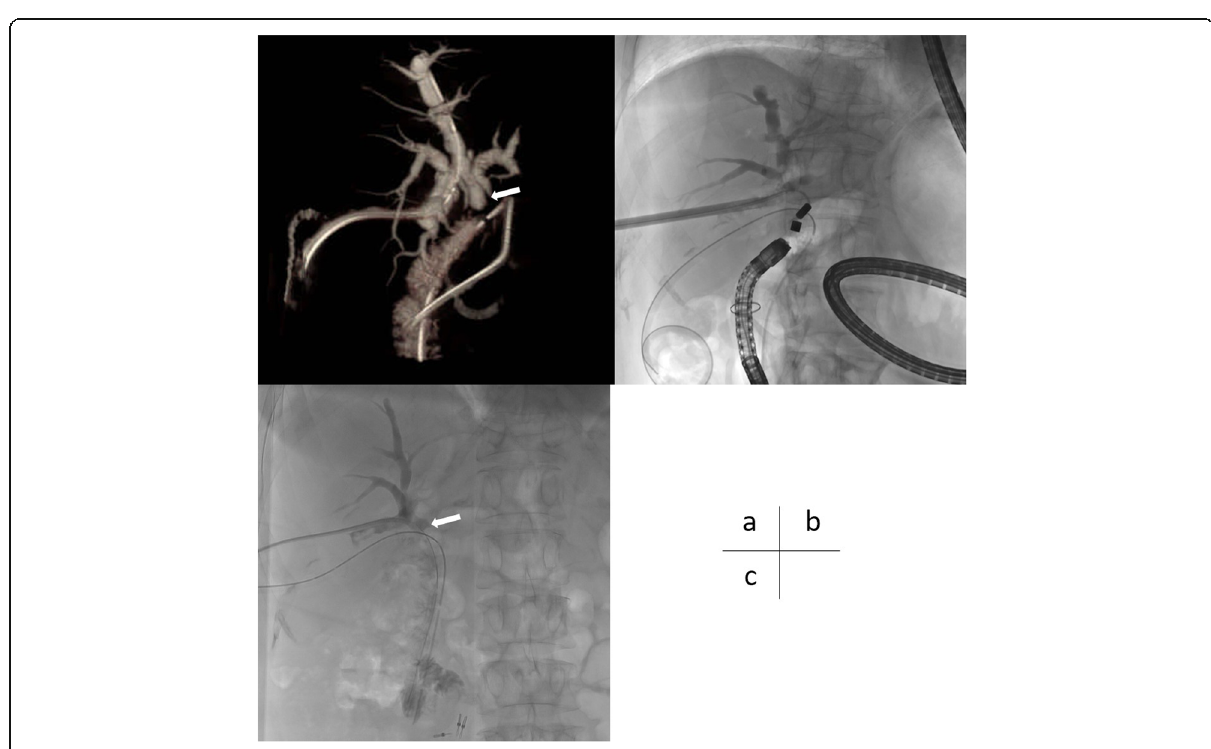
Fig. 3 a We checked the stumps of the RPD (white arrow) by 3D reconstruction of CT image. b MCA for the RPD was performed by the same procedure as that for the RAD. c The bilioenteric fistula of the RPD was completed 47 days after MCA. The PTCD tube was introduced into the bowel to maintain the fistula through re-anastomosis of RPD (white arrow). MCA magnetic compression anastomosis, RAD right anterior duct, RPD right posterior